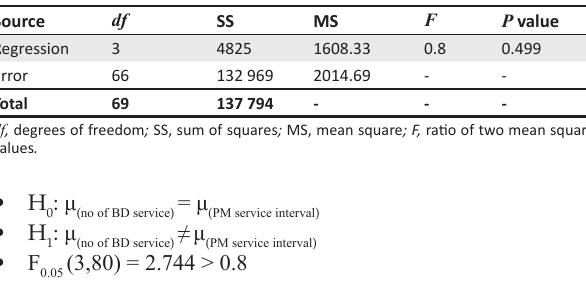
FIGURE 5: Regression of breakdown and preventative maintenance service intervals. TABLE 2: Analysis of variance of breakdown and preventative maintenance service